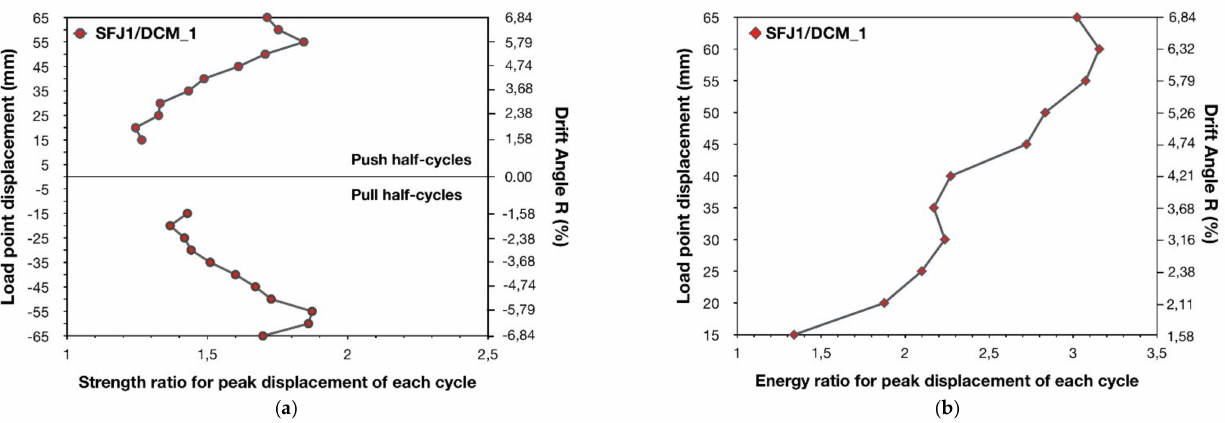
Figure 14. Plots of ( a ) load point displacement versus strength ratio for peak displacement of each cycle and ( b ) load point displacement versus energy dissipation ratio for peak displacement of each cycle of subassemblages SFJ1 and